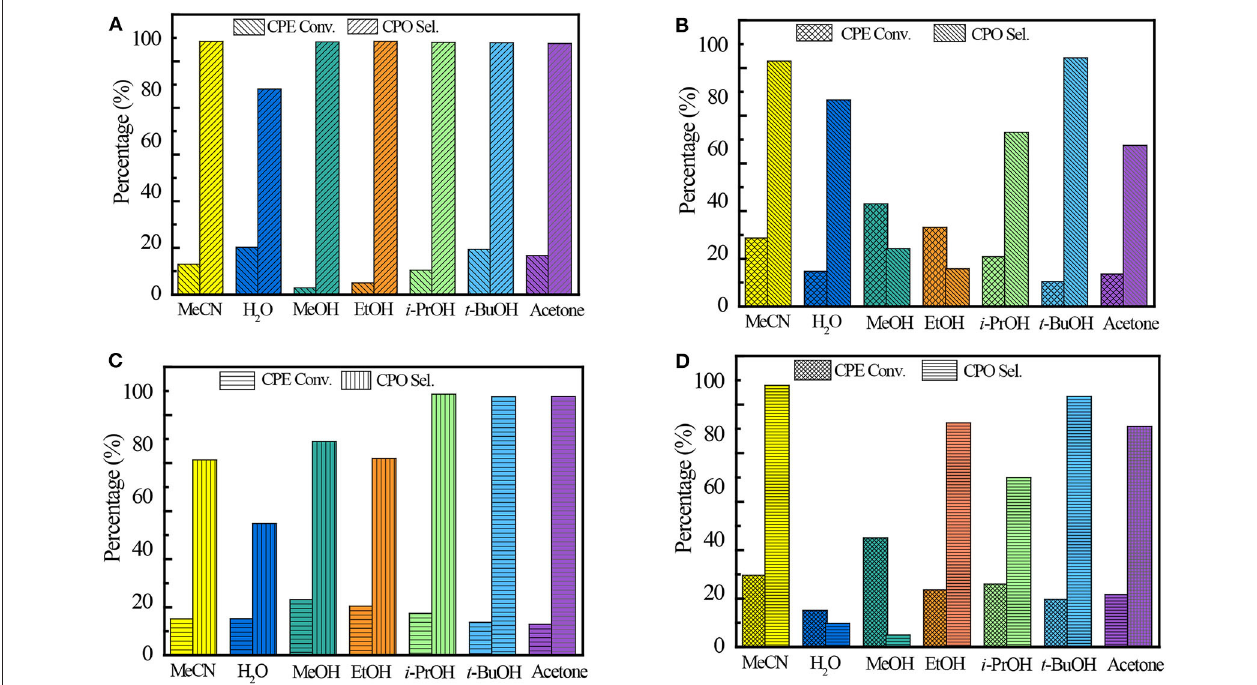
FIGURE 2 | The catalytic performance of Ti-MWW (A) , TS-1 (B) , TS-2 (C) , and Ti-MCM-68 (D) in CPE epoxidation reaction with various solvents. Reaction conditions: catalyst, 50mg; cyclopentene, 10 mmol, H 2 O 2 (30 wt.%), 10 mmol; solvent, 10mL; temp., 333K; time, 2h.